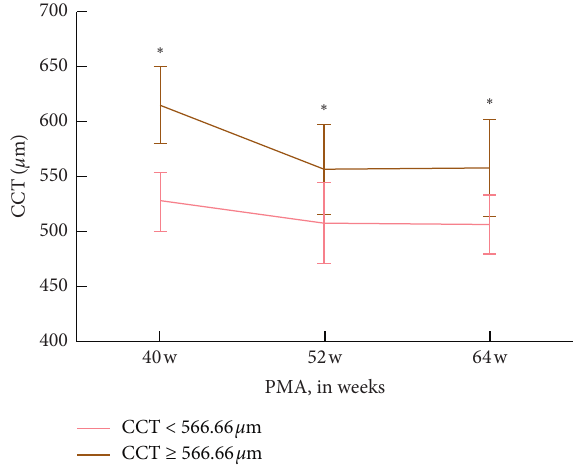
Figure 3: CCT variation trend at 40w, 52w, and 64w. ∗ P < 0 .